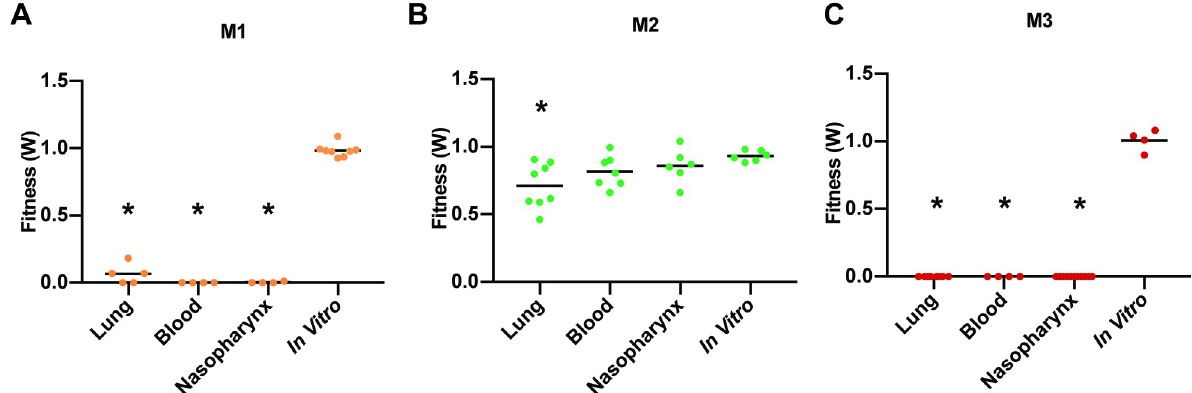
Fig 8. Regulation by the pyrR RNA element is crucial for in vivo survival and virulence of S . pneumoniae . 1x1 competition assays (mutant vs wild type T4) reveals fitness defects of pyrR RNA mutants in a mouse infection model. While M1 (A) and M3 (C) display severe defects in all the tested in vivo environments namely lung, blood and nasopharynx, M2 (B) has less of a defect. Significant change in fitness ( p < 0 . 0125) are indicated by asterisks ( � ). Each data point represents a single